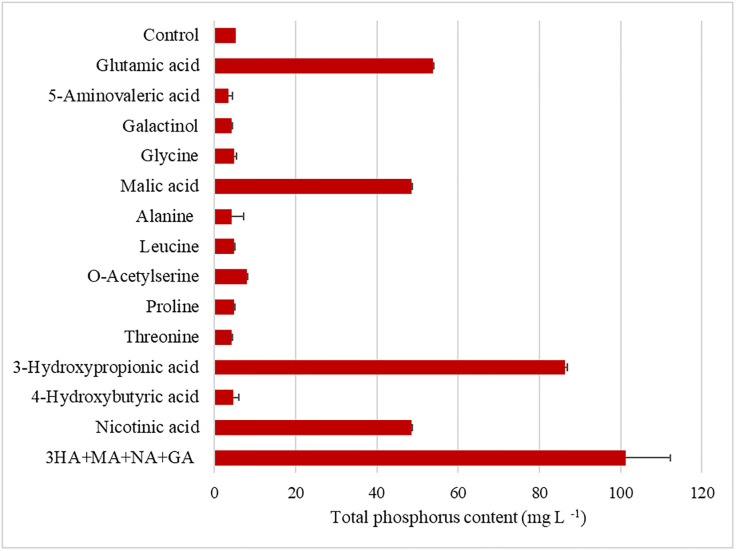
Quantitative phosphate-solubilization analyzed by coupled plasma-Optical Emission Spectrometer (ICP-OES) in 13 identified compounds.Available phosphorus content in NBRIP liquid media after incubation of 72 hours with each of the 13 compounds at 7mM concentration. 3HA+MA+NA+GA treatments is the combination of 3-hydroxypropionic acid (3HA), malic acid (MA), nicotinic acid (NA) and glutamic acid (GA). Each compound added to the pool had 1.75 mM, 7 mM and 28 mM concentration.